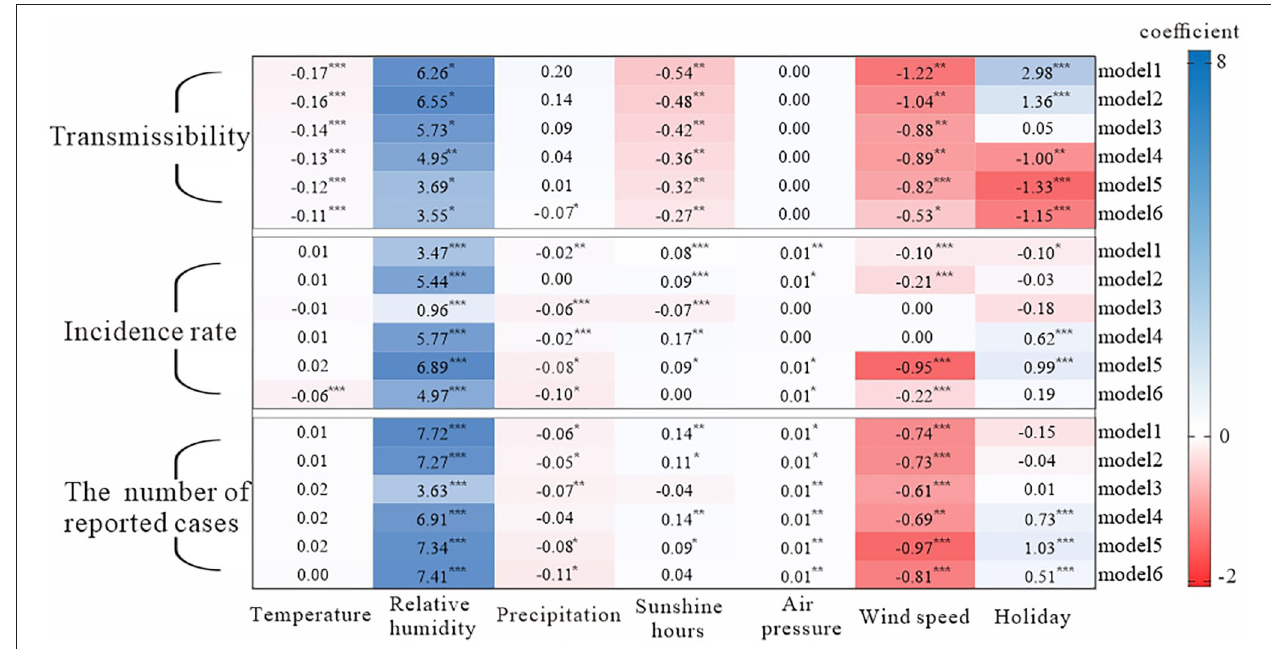
FIGURE 3 | Analysis results of influencing factors based on the generalized estimation equation. Model 1: the just-in-time effect model; model 2: 1 day lag effect model; model 3: 2 days lag effect model; model 4: 3 days lag effect model; model 5: 4 days lag effect model; model 6: 5 days lag effect model; p is based on the results of the generalized estimating equation; *** = p < 0.001; ** = p < 0.01; * = p < 0.1. All correlation coefficients |r| were < 0.8, so there was no strong correlation between x1 and x6; the variance inflation factor (VIF) values among all covariates were between 1.21 and 3.58, so the collinearity between x1 and x6 in models 1–6 was not